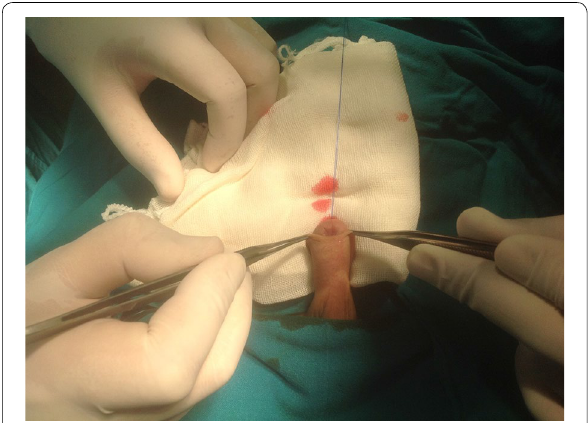
Fig. 2 Ensuring the flap will be of adequate length without inducing penile curvature